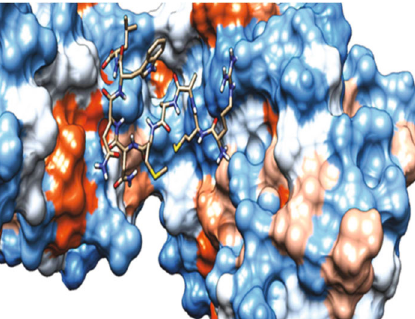
Figure 17: Illustration of the 2D interaction of the best docking poses of RMAAMNQWL in the binding sites of HLA-A ∗ 02:06.